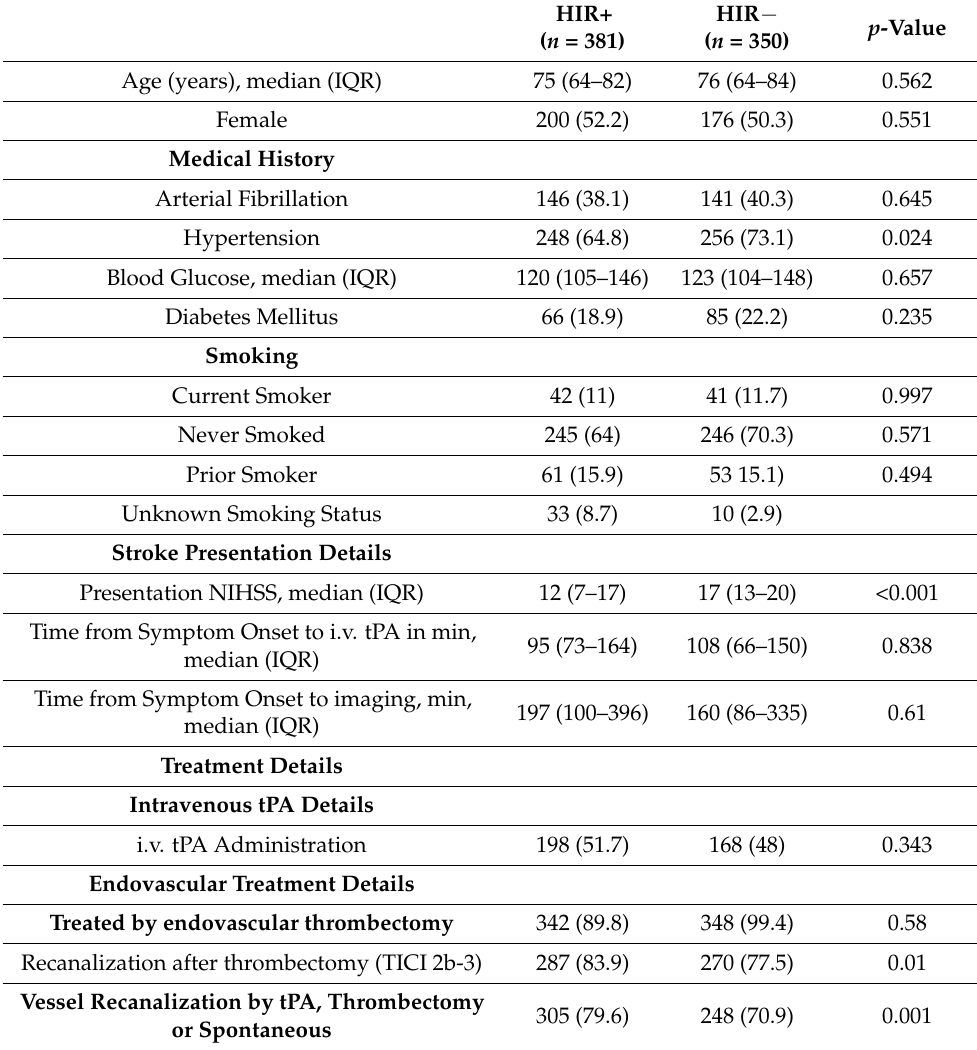
Table 1. Patient characteristics and stroke presentation details dichotomized by the hypoperfusion intensity ratio a